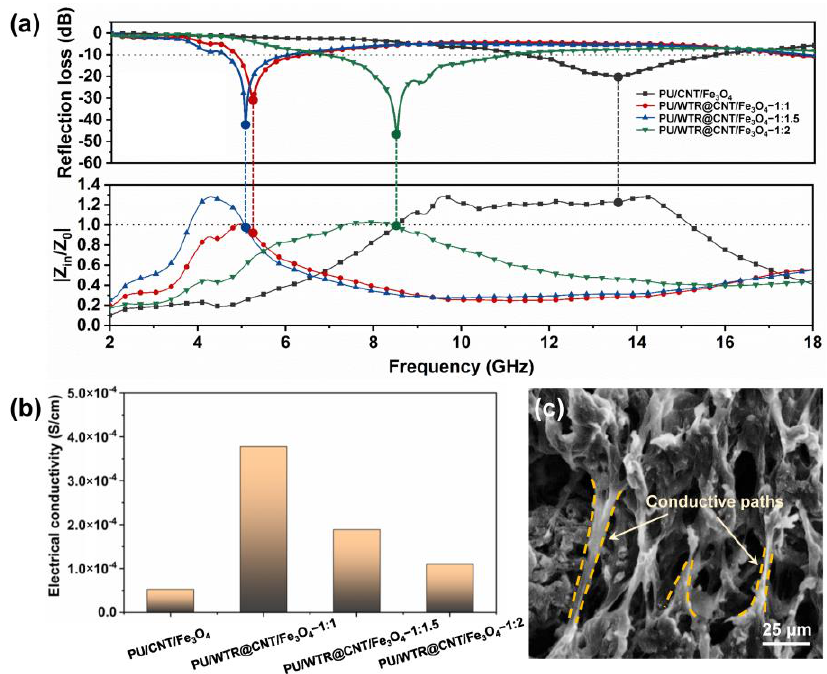
Figure 5. ( a ) The RL and |Z in /Z 0 | of the composite foams at different frequencies. ( b ) The σ and ( c ) conductive network structure of the composite foams.